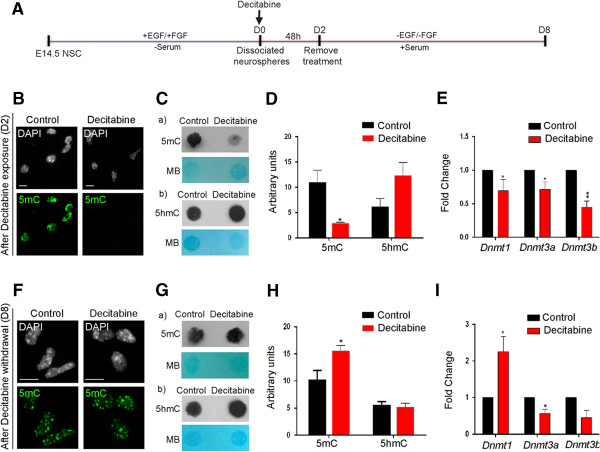
Effect of decitabine on global DNA methylation (5mC and 5hmC) and Dnmt genes in differentiating neural stem cells (NSC). (A) Schematic representation of decitabine treatment. Briefly, 2.5 μM of decitabine was added to dissociated neurospheres on day 0 (D0) at the onset of NSC differentiation for 48 h, and the treatment was withdrawn at D2. Cells were kept in culture till D8. Top panel (B-E), after exposure to decitabine at D2. (B) Immunofluorescent detection of DNA methylation using 5-methylcytosine (5mC) antibody. Decitabine caused reduced levels of DNA methylation, note the presence of 4',6-diamidino-2-phenylindole (DAPI) signals in decitabine-treated cells with no 5mC signal. Scale bars represent 5 μm. (C) Detection of overall DNA methylation levels by DNA dot blot with antibodies specific for (a) 5mC, (b) 5-hydroxymethylcytosine (5hmC). (D) Quantification of the 5mC and 5hmC levels after decitabine exposure. (E) Detection of Dnmt transcript levels by qRT-PCR. Bottom panel (F-I), after withdrawal of decitabine at D8. (F) DNA methylation detection by immunofluorescence using 5mC antibody. Scale bars represent 5 μm. (G) Detection of global DNA methylation levels by DNA dot blot, (a) 5mC, (b) 5hmC. (H) Quantification of 5mC and 5hmC levels after withdrawal of decitabine. (I) Detection of Dnmt transcript levels by qRT-PCR. Fold changes are calculated relative to transcript levels at D2 or D8 control; n = 3 ± standard error of the mean. Significant differences from control: **P <0.01; *P <0.05. MB, methylene blue (used for visualizing total DNA).